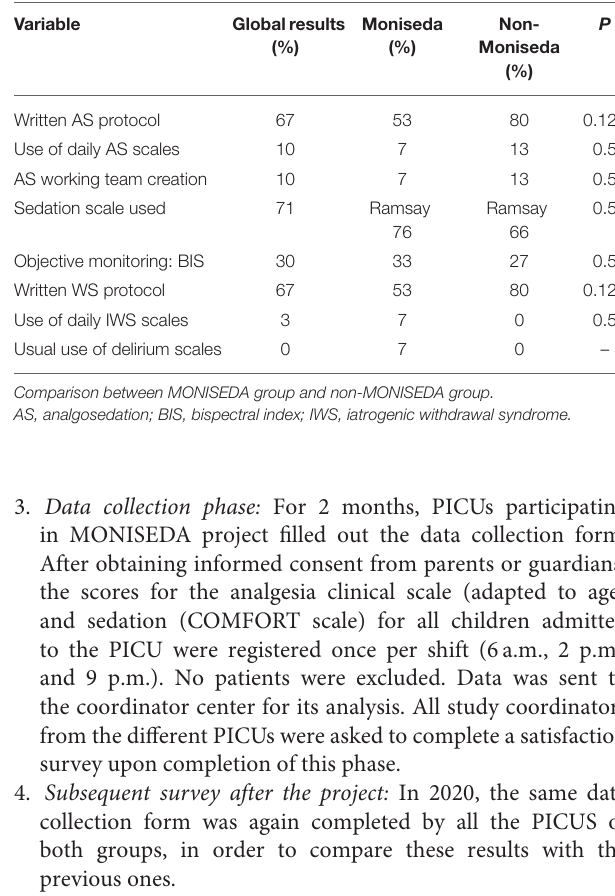
TABLE 2 | Initial analgosedation survey (year 2015). TABLE 3 | Satisfaction survey of MONISEDA group 2016.